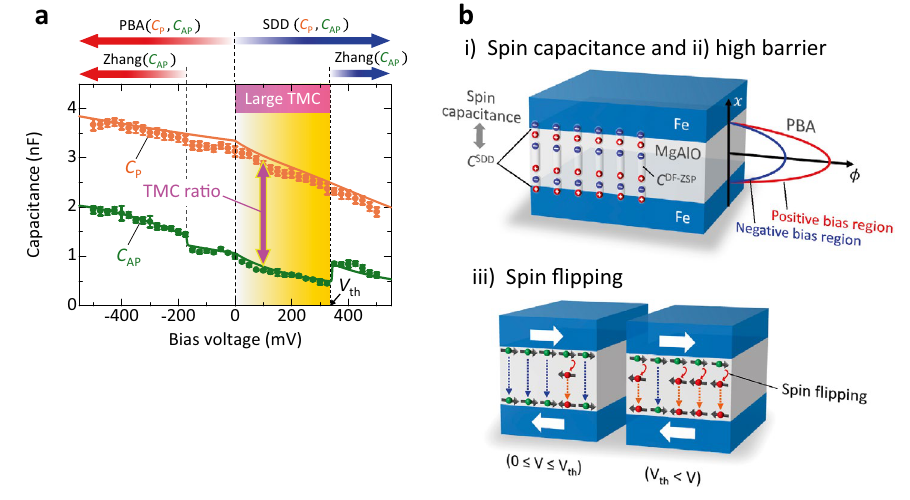
Figure 6. Mechanism of a large TMC. ( a ) Capacitance C P(AP) in the P (AP) configuration for an Fe/MAO/ Fe MTJ (sample B) at 140 Hz. The large TMC originates from the appearance of the spin capacitance which is described by SDD model. ( b ) Schematic of the mechanism of large TMC: (i) the spin capacitance appears in the Fe/MAO interface, (ii) the barrier height of MAO is high at 1.8–2 eV, and (iii) the spin flipping does not occur in the bias region from 0 to 325 mV.